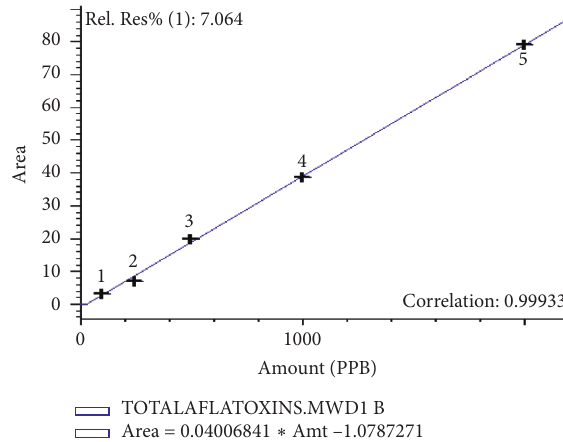
Figure 1: Calibration curve of total aflatoxin in ppb using five concentrations.